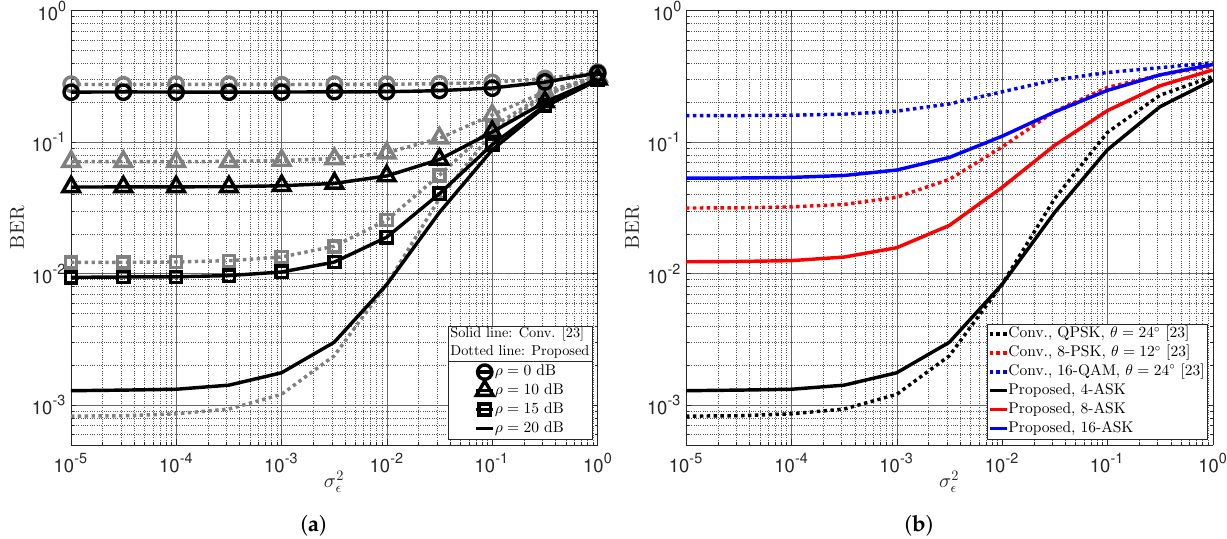
Figure 5. Average BER performance of two STAs in the proposed low-complexity uplink STLC- NOMA and conventional STLC-NOMA systems with channel estimation error. ( a ) The proposed STLC-NOMA with 4-ASK and conventional STLC-NOMA with QPSK for varying SNRs. ( b ) The proposed STLC-NOMA with M -ASK and conventional STLC-NOMA with M -PSK/QAM for an SNR of 20